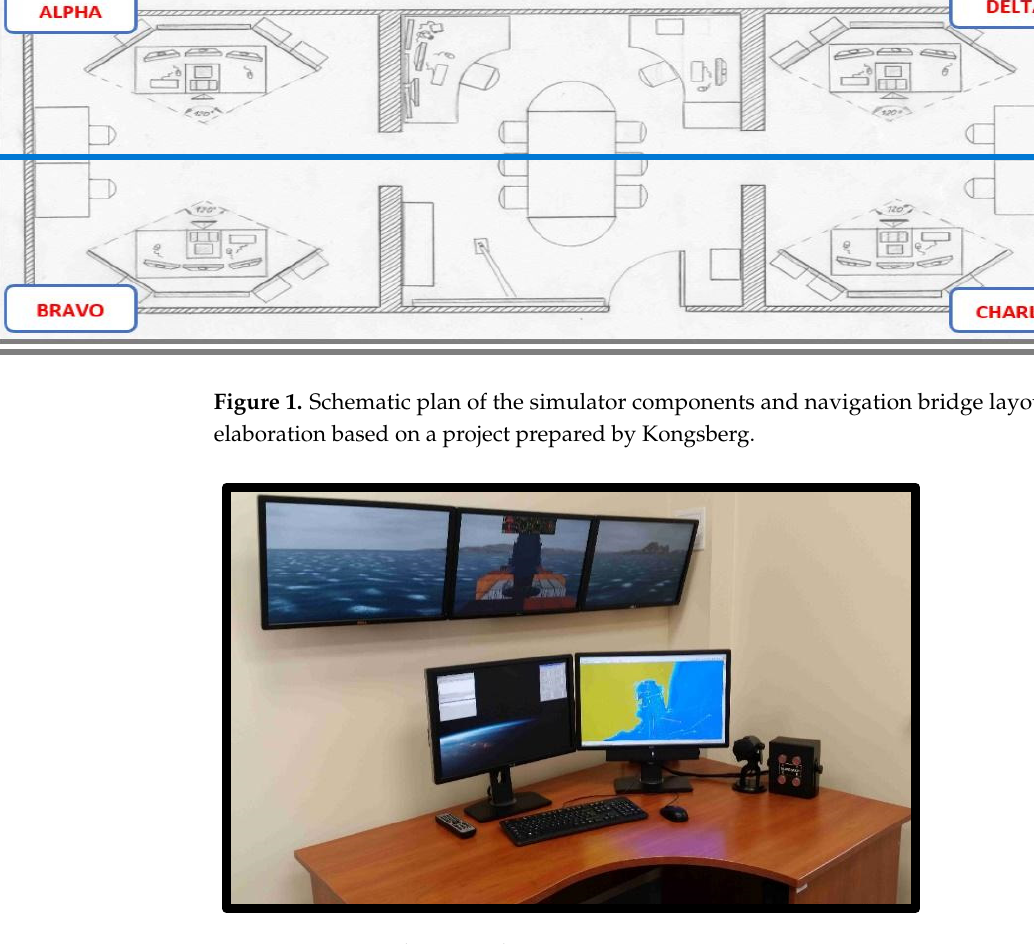
Figure 2. K-Sim Polaris simulator instructor station.